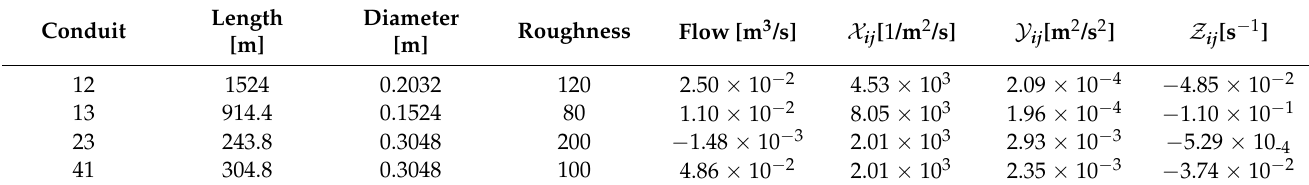
Figure 1. ( a ): schematic overview of the triangular network, where R is the reservoir and conduit 41 has a flow sensor. ( b ): Eigenvalue decomposition of the corresponding observability Gramian W O of the triangular network, with only a flow sensor in conduit 41, where each column represents an eigenvector of W O and each column label at the bottom has the corresponding eigenvalue λ W . O Table 1. Network conduit properties of the triangular network.